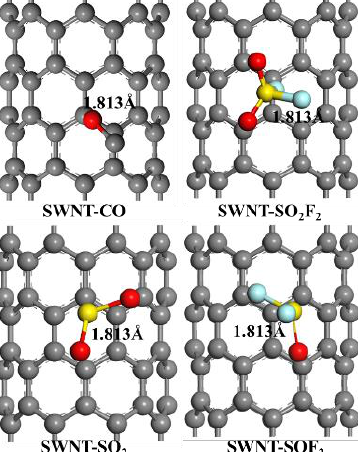
Figure 5. Adsorption structures of four gas molecules on single-walled carbon nanotubes. Table 2. Adsorption energies of four gas molecules on single-walled carbon nanotubes.